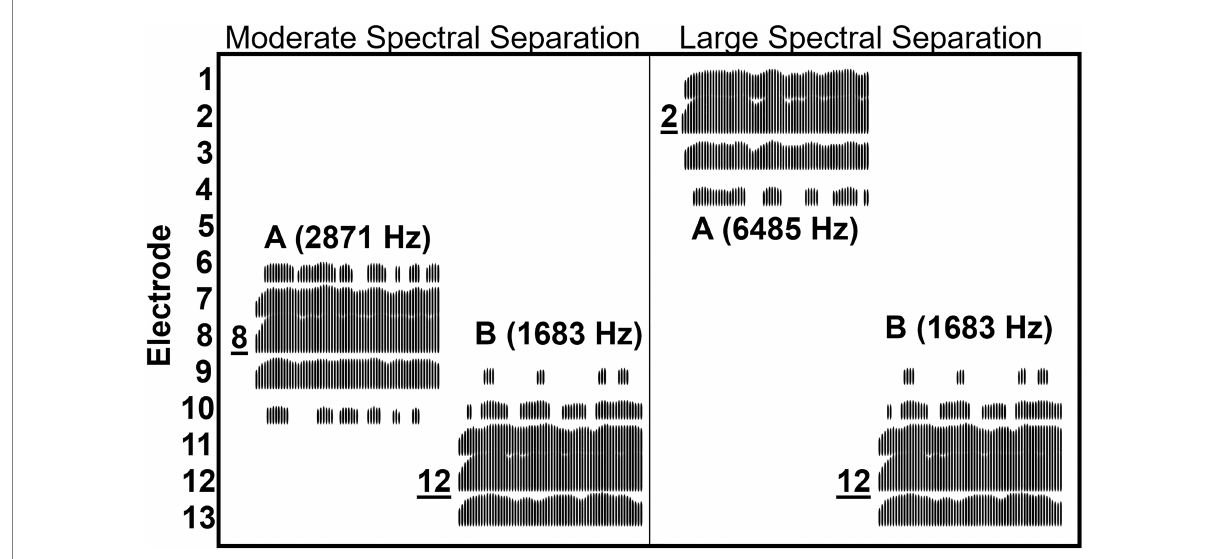
FIGURE 2 Electrodogram illustrating the electrodes activated by A and B narrowband bursts when they were at the moderate and large spectral separations for the three CI users, for whom the frequencies of stimulus bursts were identical. The electrodogram was generated based on the ACE processing strategy all three CI users used with a default frequency allocation (188–7,938 Hz), stimulation rate (900 Hz), and eight maxima. The A and B bursts are labeled with their corresponding center frequencies in the parentheses. The electrodes are ordered vertically starting from the most basal electrode #1 at the top through electrode #13 at the bottom. Direct labeling with underlined numbers indicate those electrodes to which the A and B bursts were assigned. Note that an A or B burst activated four or five electrodes and did not produce any activation on electrodes #5 and #14–20. The electrodes #14–20 are not shown in the